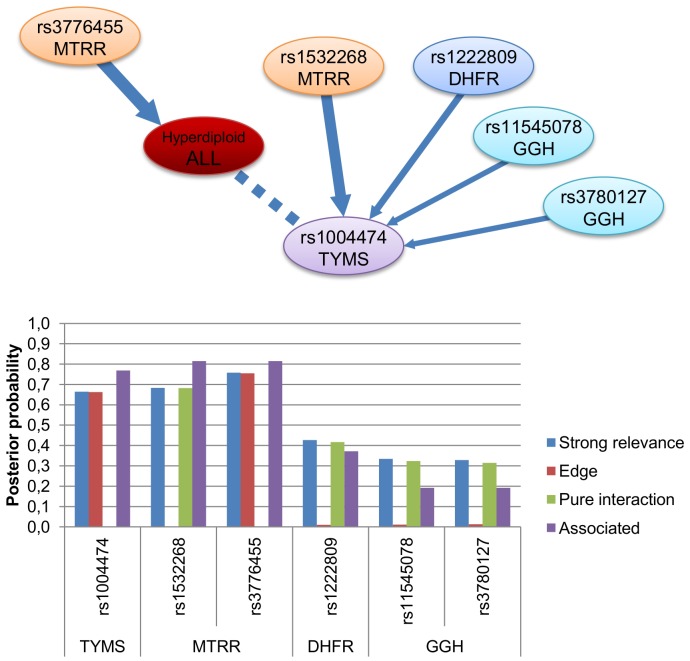
Illustration of different dependency relations between relevant SNPs and hyperdiploid ALL susceptibility.Top panel: An interactional map including hyperdiploid ALL susceptibility (red node) and strongly relevant SNPs with respect to it (other nodes). The width of the edges is proportional to their a posteriori probability. The directed edges represent only probabilistic relationships between the variables which are not necessary causal. Bottom panel: The posterior probability of strong relevance (blue columns), edge (direct strong relevance, red columns), pure interaction (green columns) and association (purple columns) of the variables to hyperdiploid ALL susceptibility according to the BN-BMLA method.